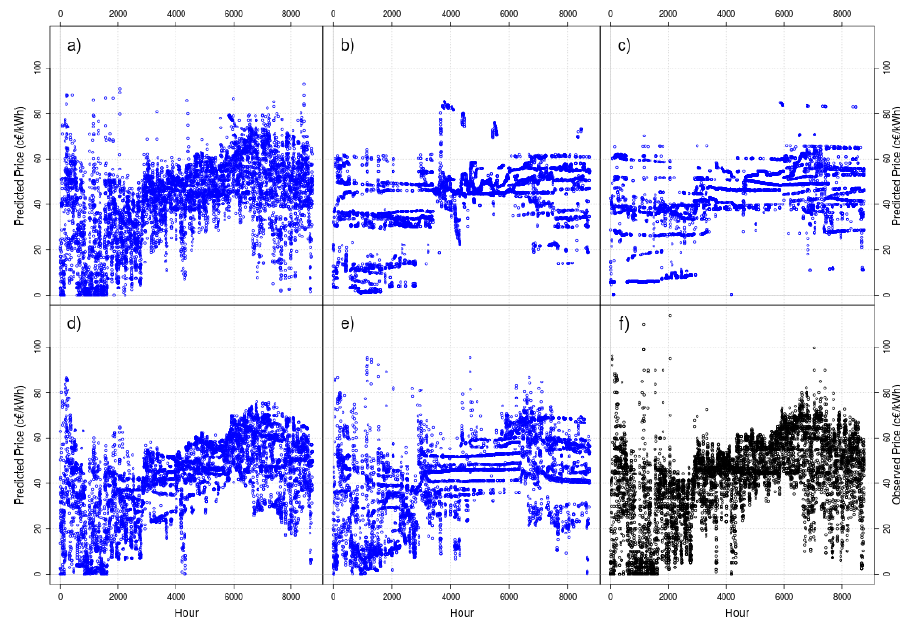
Figure 2. As blue points, one-hour ahead forecasts of Dynamic Trees (DT) with constant mean for a moving window of 10 days. ( a ) Full model, ( b ) retire the oldest data, ( c ) retire the data discarded by active learning, ( d ) retire the oldest data and rejuvenate the particle set and ( e ) retire the data discarded by active learning and rejuvenate the particle set. As black points, ( f ) the 2014 real data to forecast.